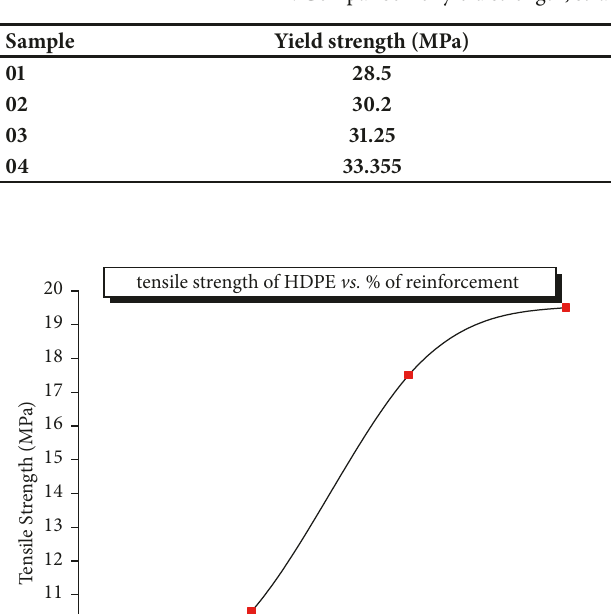
Table 2: Comparison of yield strength, strain at failure, and elongation of HPMC samples.